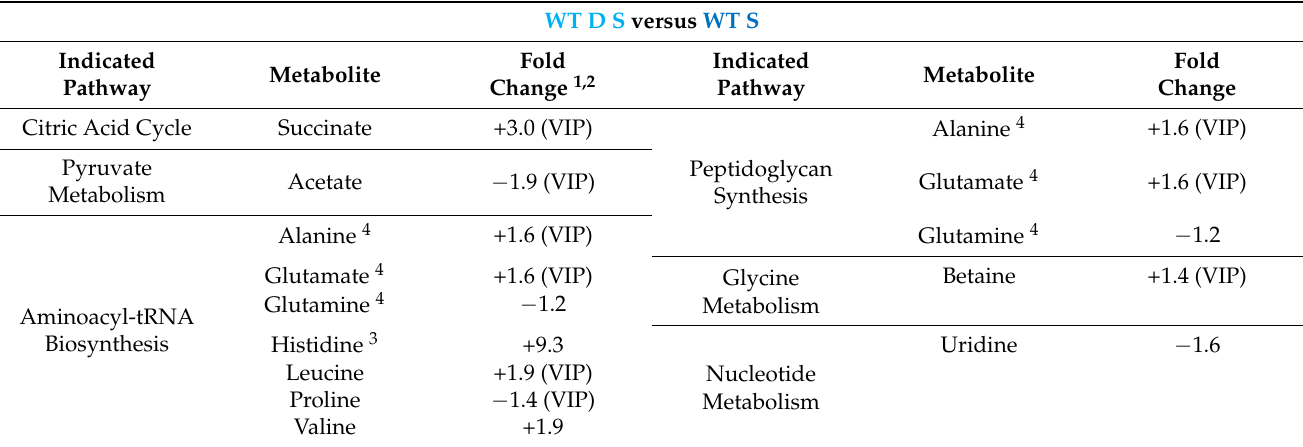
Table 7. Fold change of statistically significant metabolites in their corresponding metabolic pathways for the stationary phase of DABCOMD challenged wild type versus unchallenged wild type.